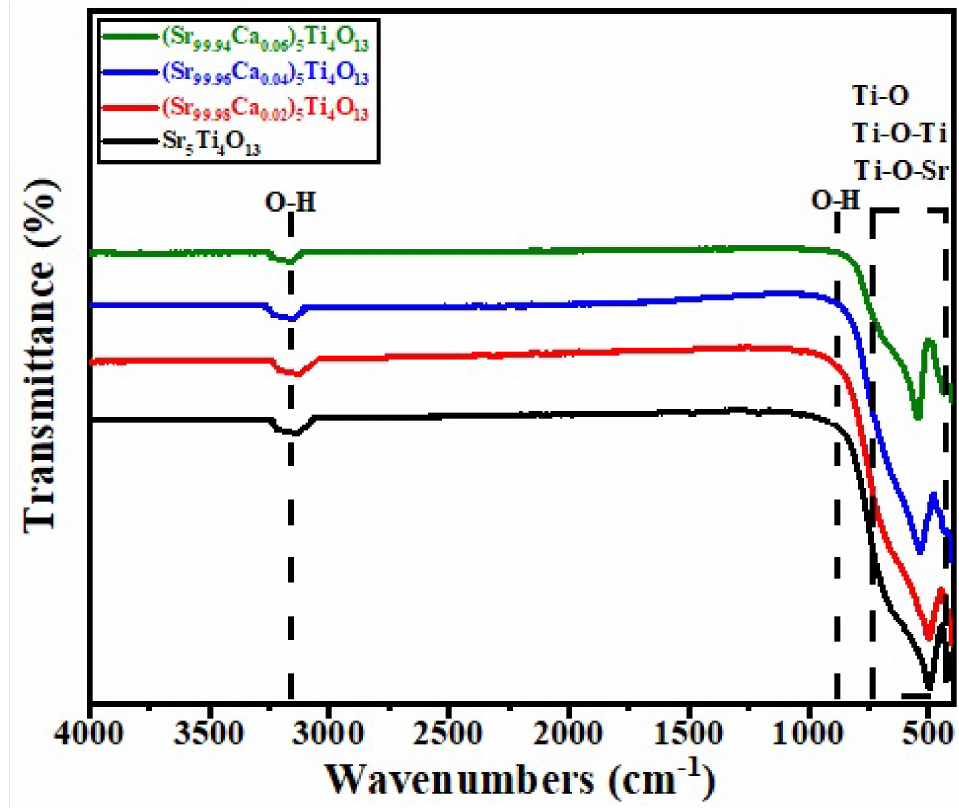
Figure 4. FTIR spectra of (Sr 1 − x Ca x ) 5 Ti 4 O 13 , 0 ≤ x ≤ 0.06 sintered